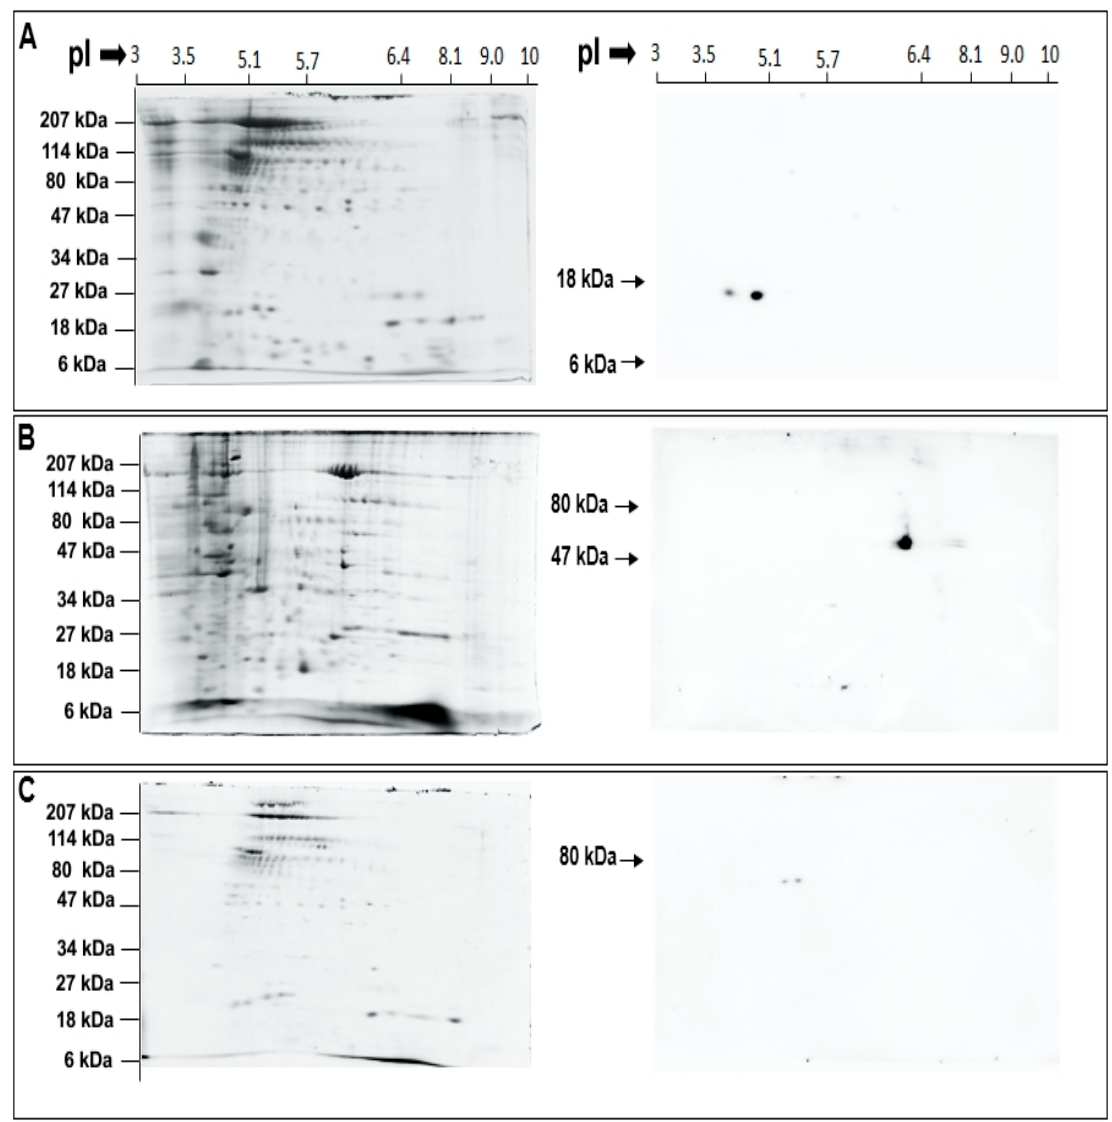
Figure 4. Immuno-reactive spots detected by ( A ) sPLA 2 antibody in the CV luminal fraction; ( B ) iPLA 2 antibody in the CSC membrane fraction; and ( C ) iPLA 2 antibody in the CV membrane fraction. cCBB stained 2D SDS-PAGE gels (left) and parallel western blots (right).